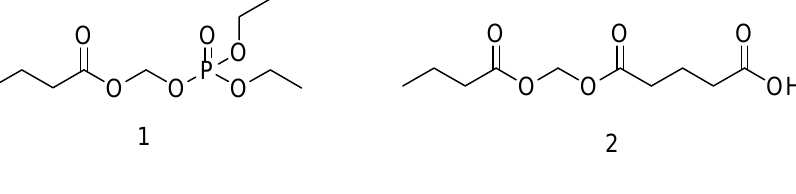
Figure 46 : Neutral (1) and acid (2) derivatives of butyric